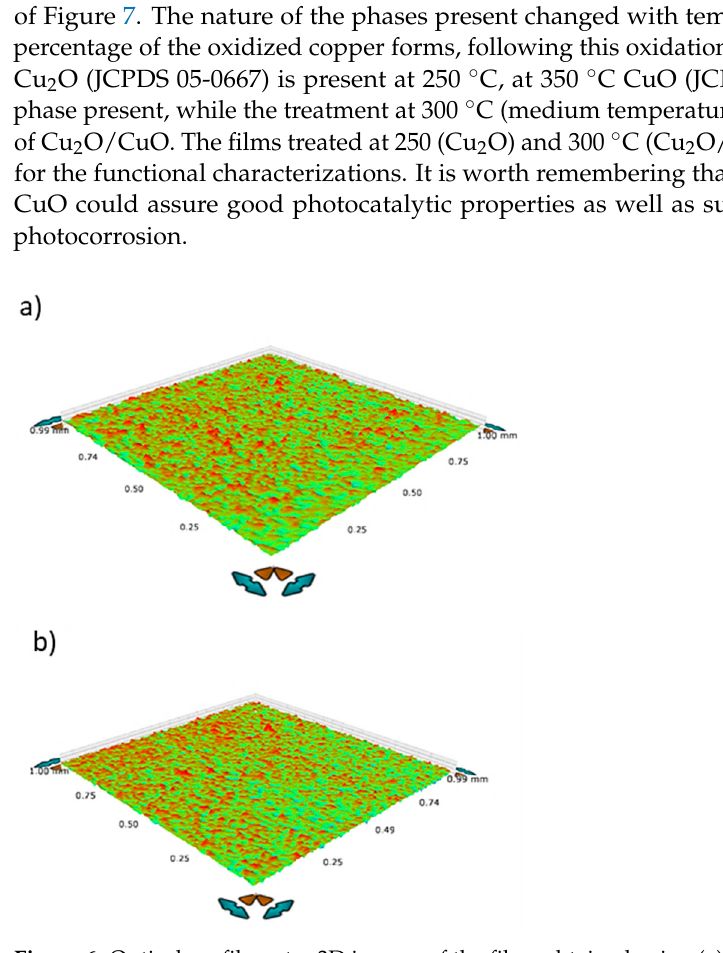
Figure 6. Optical profilometer 3D images of the films obtained using ( a ) ink_25 and ( b ) ink_55.